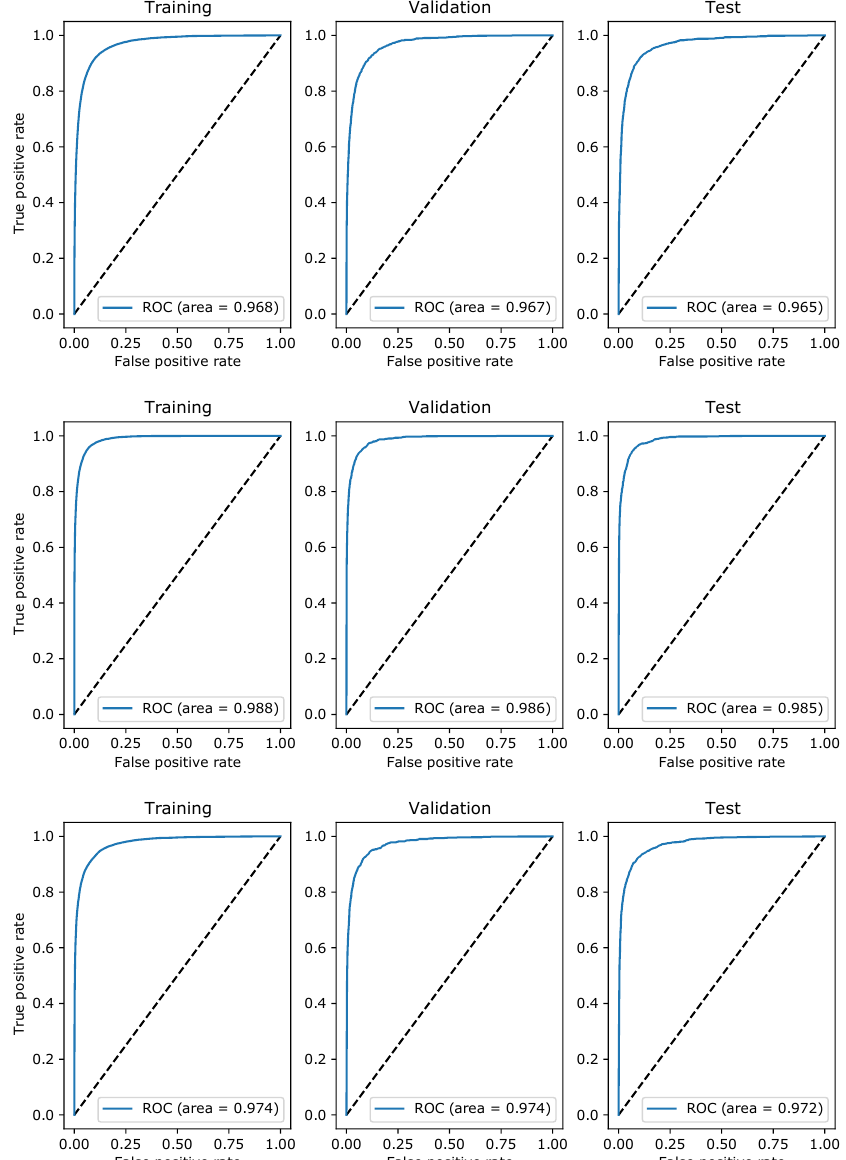
Figure 12. Receiver Operating Characteristic (ROC) curves for SGD, Adam, and RMSprop optimizers, respectively, with the learning rate of 0.001 and 100 epochs.